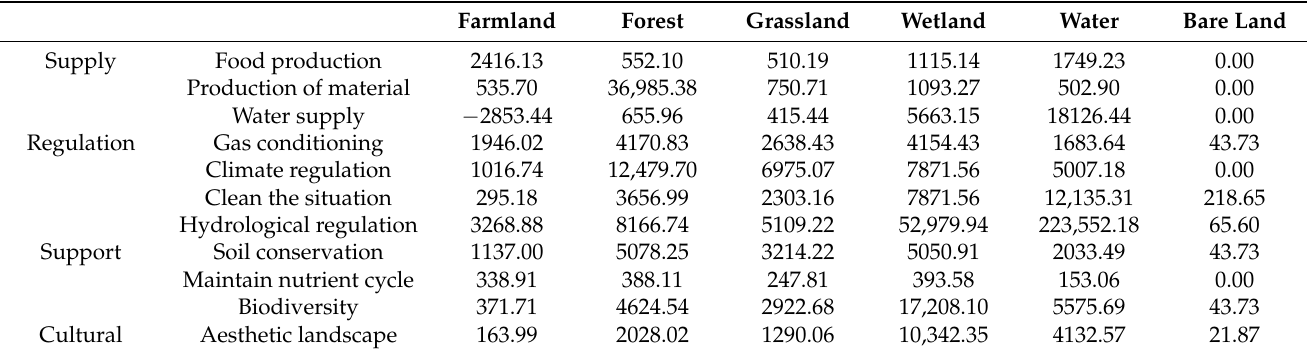
Table 3. The ESVs coefficient per unit area in Wuhan (CNY · hm − 2 · a − 1 ). Farmland Forest Grassland Wetland Water Bare